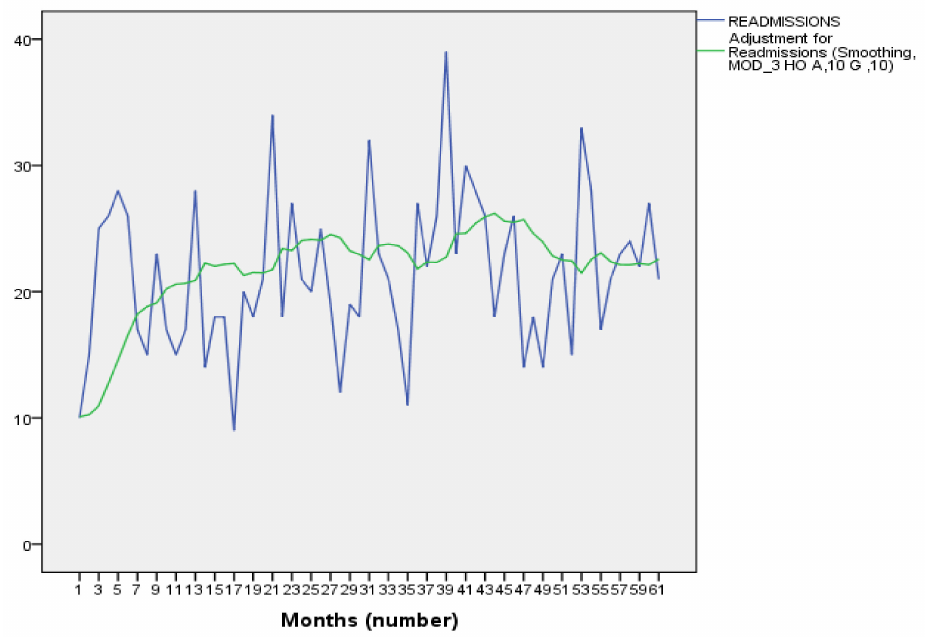
Figure 1. Time series of monthly